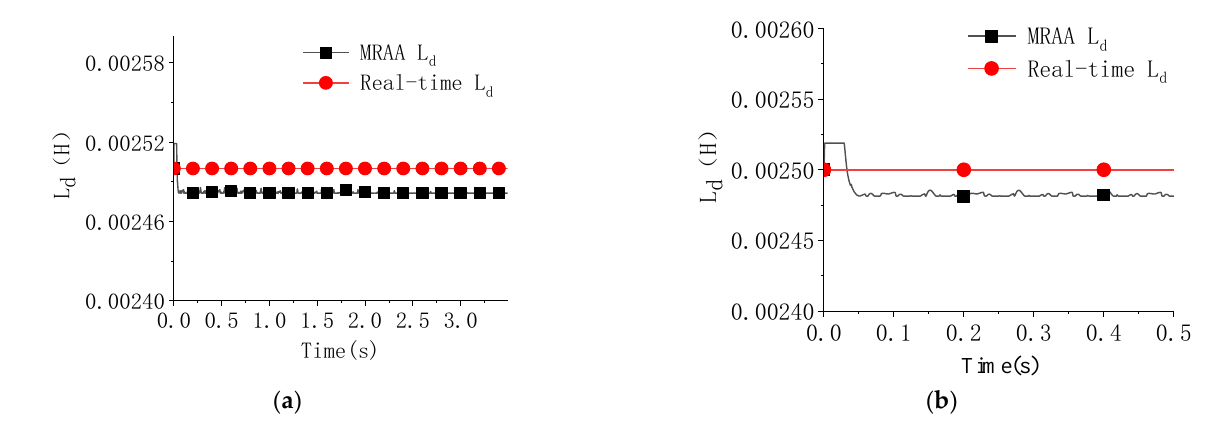
Figure 10. Comparison between the MRAA-identified flux linkage and actual flux linkage. ( a ) Com- parison of flux linkage and ( b ) the local magnification of the anterior segment.